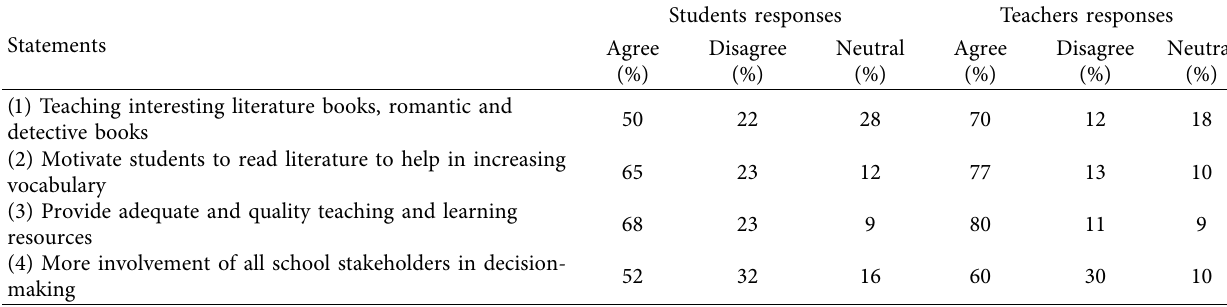
Table 4: Summary of subjects’ responses to actions taken to improve the